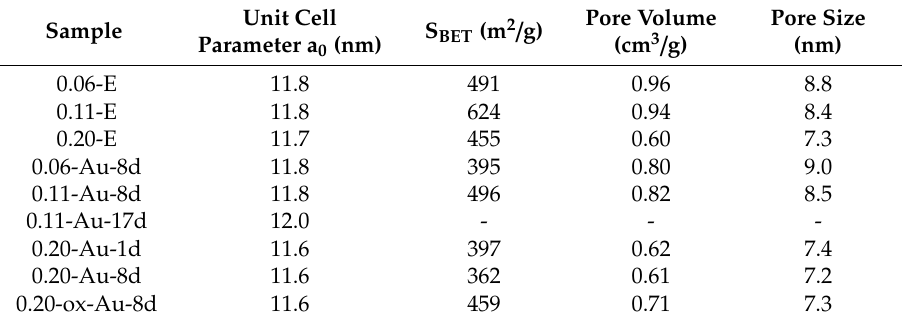
Table 1. Structural and textural parameters of the supports and Au-containing